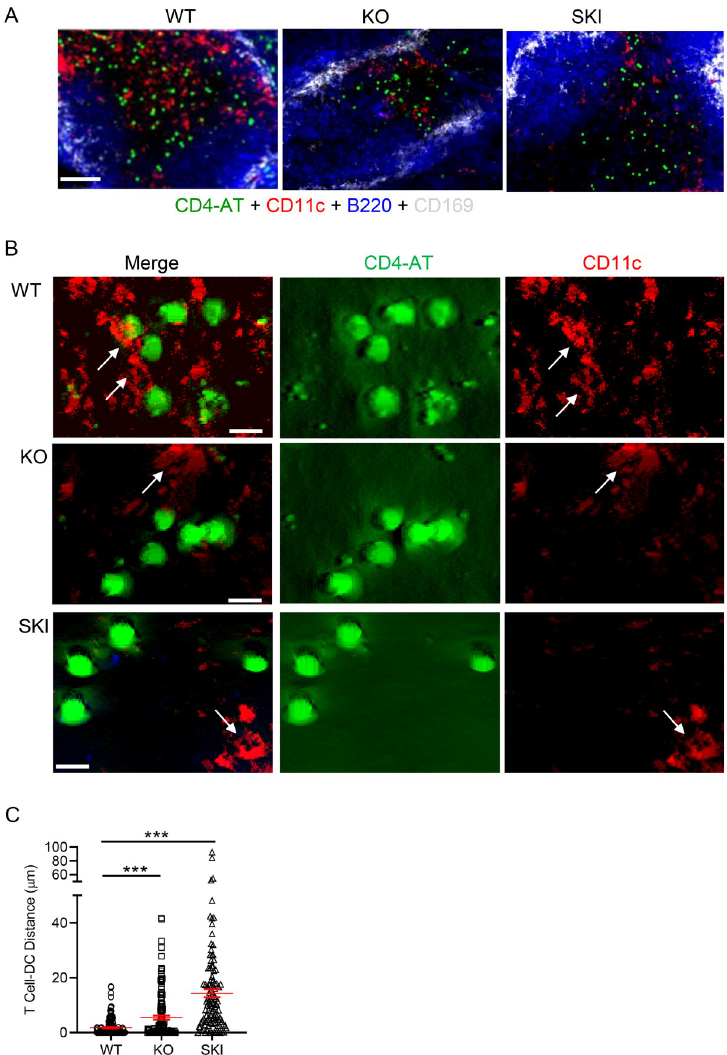
Fig 6. Reduced CD4 + OTII T cell proximity to CD11c + DCs in Cd47 KO and SKI splenic T cell zones. (A) CFSE- labeled WT OTII T cells (4x10 6 ) were i.v. injected into Cd47 KO, SKI and WT recipient mice. Twenty-four hrs later, spleens were harvested and processed into frozen blocks. Four-color immunofluorescence microscopy of transferred CFSE + OTII T cells, CD11c + , B cell follicles and CD169 + marginal zone macrophages within the splenic white pulp. Data are representative of 3–5 replicate sections from 3 mice per group. Calibration bar, 100 μ m. (B) Immunofluorescence microscopy of CFSE + T cells (green) and CD11c + DCs (red) within T cell zone. Arrows identify CD11c + DCs. Representative of 3 mice per group. Scale bars, (A) 25 μ m and (B) 5 μ m. ( C ) Proximity of CFSE CD4 + OTII T cells (green) to splenic CD11c + (red) DCs in T cell zones of splenic white pulp in mice immunized with OVA protein. The number of CFSE + T cells in T cell zone analyzed were WT, 154; Cd47 KO, 135; SKI, 109. ��� p < 0.0001 by one-way ANOVA with Welch’s correction.